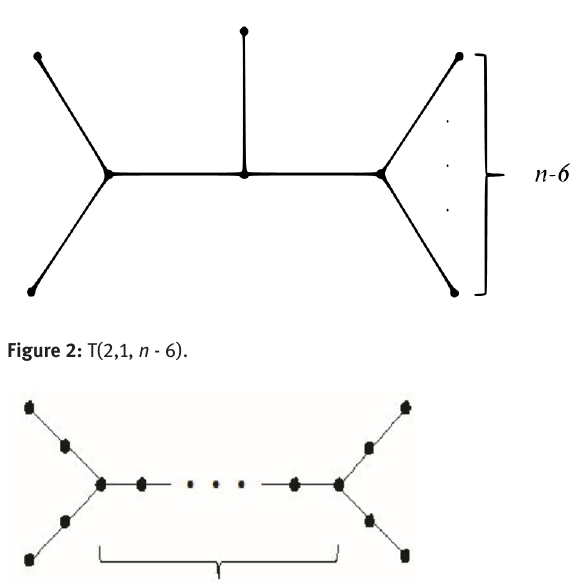
Figure 1: T(2, n - 4).